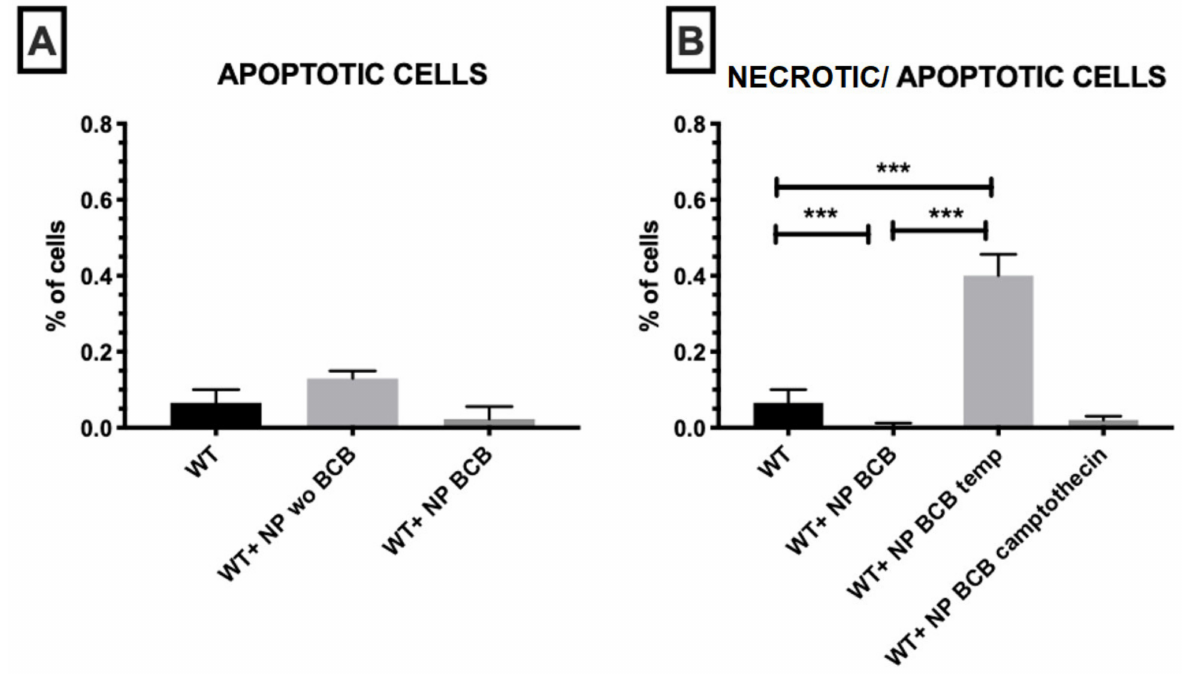
Figure 10. Necrosis/apoptosis observed in examined myoblast cell populations influenced by various types of inductors. ( A ) apoptosis of SkM cells incubated with nanoparticles loaded or unloaded with BCB in comparison to wildtype cells, n = 3. ( B ) induction of necrosis and programmed cell death by SkM incubation in high temperature or treated with camptothecin, n = 3. Respectively, statistical significance legend: p < 0.05 (*), p < 0.01 (**), p < 0.001 (***). Results were obtained using the one-way ANOVA test. Abbreviations: WT—wild type cells; WT campto—wild type cells treated with camptothecin;